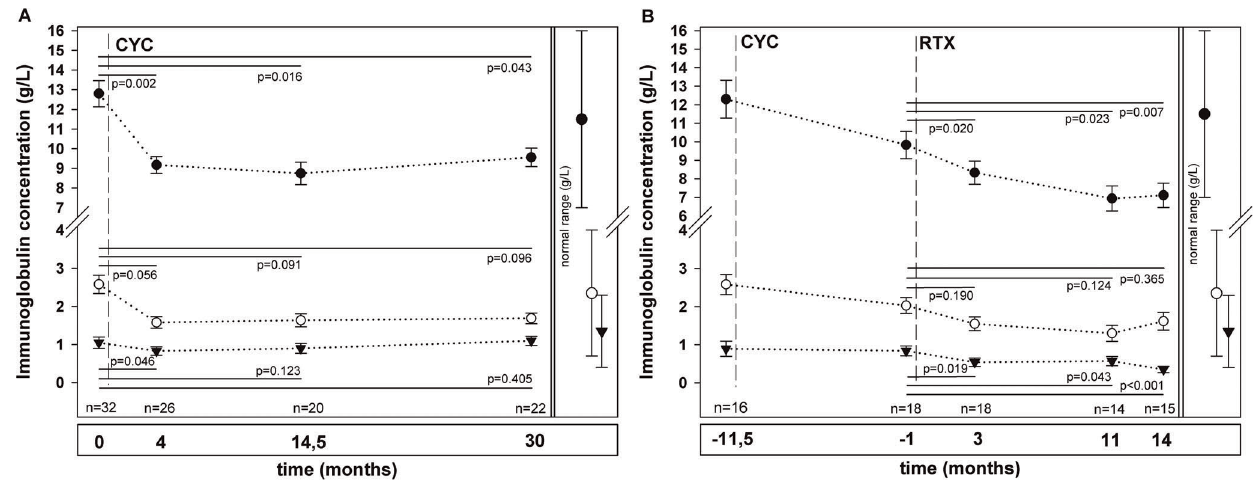
Figure 1. Effect of CYC treatment and CYC treatment followed by RTX on serum Ig concentrations in AAV patients. Vertical dashed lines indicate the time of treatment with CYC ( A ) and CYC followed by RTX ( B ). Black circles stand for IgG concentrations, open circles for IgA concentrations, and black triangles for IgM concentrations. Vertical bars on the right represent the normal ranges of IgG, IgA and IgM serum concentrations. Median 6 SE are reported.